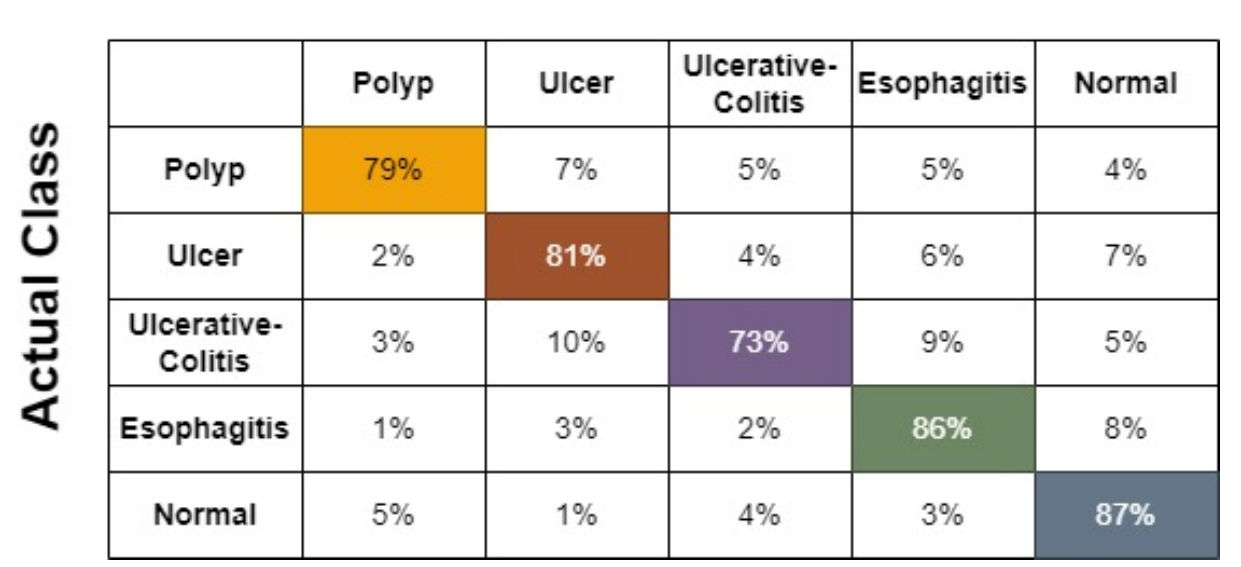
Figure 5. Accuracy results for various train - to - test ratios using original dataset.